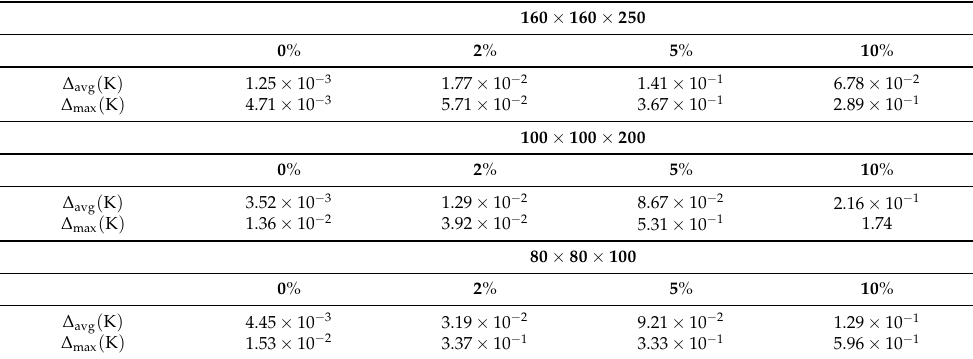
Table 6. Errors of reconstruction function u in measurement points for seven measurement points ( ∆ avg —average absolute error, ∆ max —maximum absolute error, δ avg —average relative error, δ max — maximum relative error).